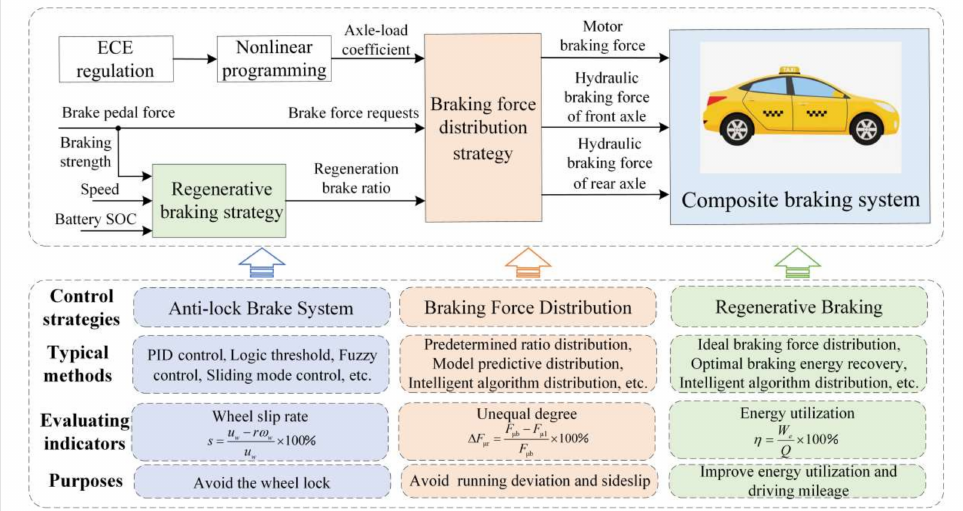
Figure 4. The characteristics of the control strategies and the upper coordination